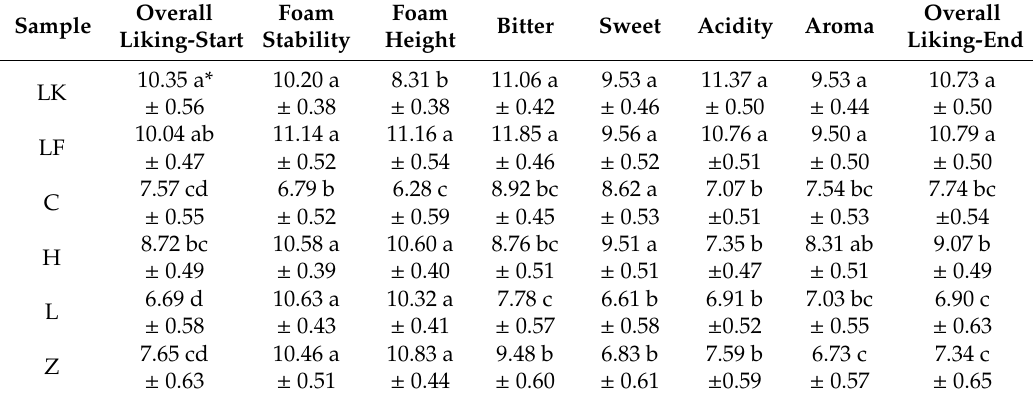
* Values represent the mean ± standard error N = 61. Di ff erent letters within a column indicate that values are significantly di ff erent according to the least significant di ff erence test (LSD; p < 0.05). Abbreviations of samples may be found in Table